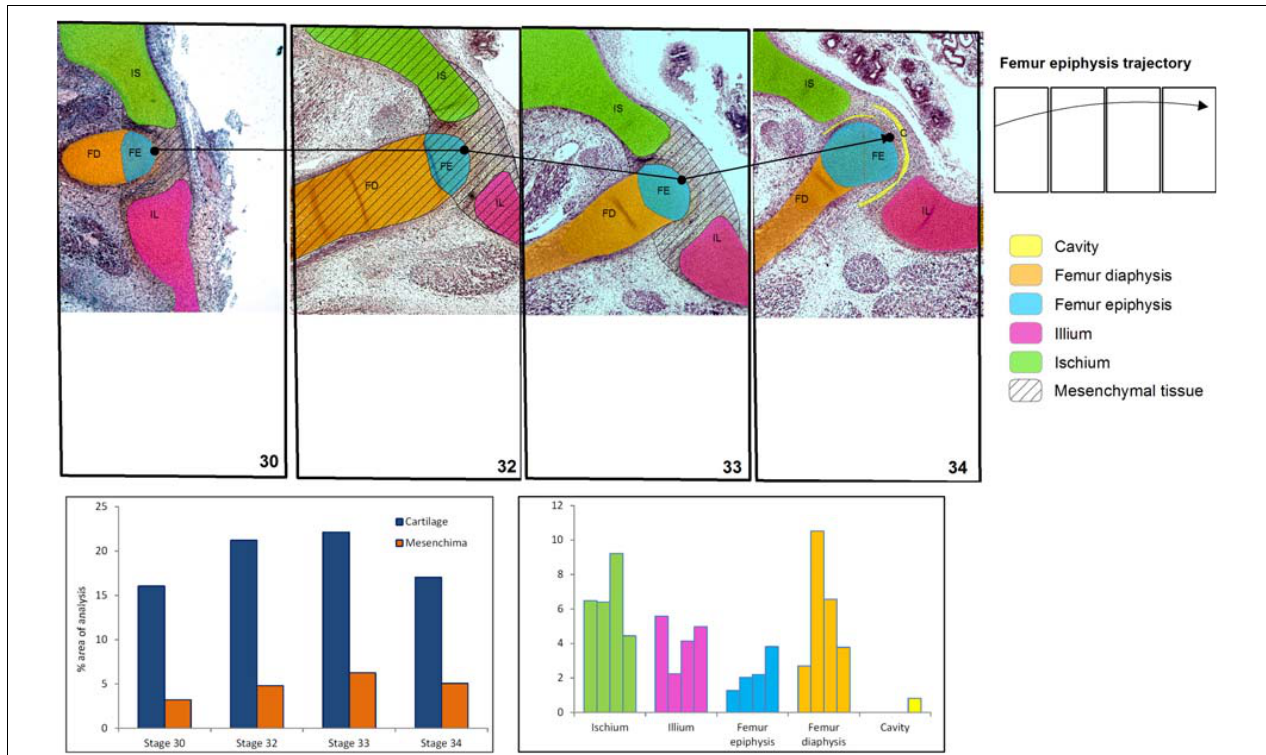
FIGURE 3 | Chicken histological cuts between Stages 30 and 34 HH (Nowlan and Sharpe, 2014) showing the increase in size and change of location of the pelvic girdle tissues and structures. In the frequency histograms the growth of the structures is